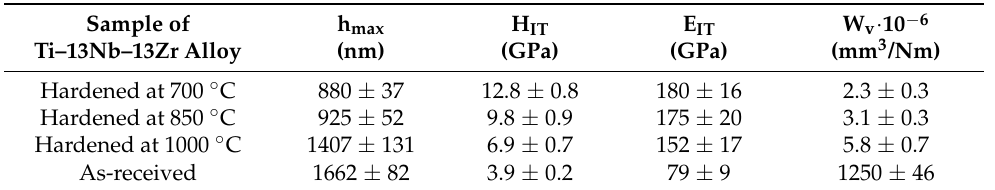
Table 1. Microhardness (H IT ), elastic modulus (E IT ), the penetration depth of the indenter (h max ), and wear rate (W v ) of the Ti–13Nb–13Zr